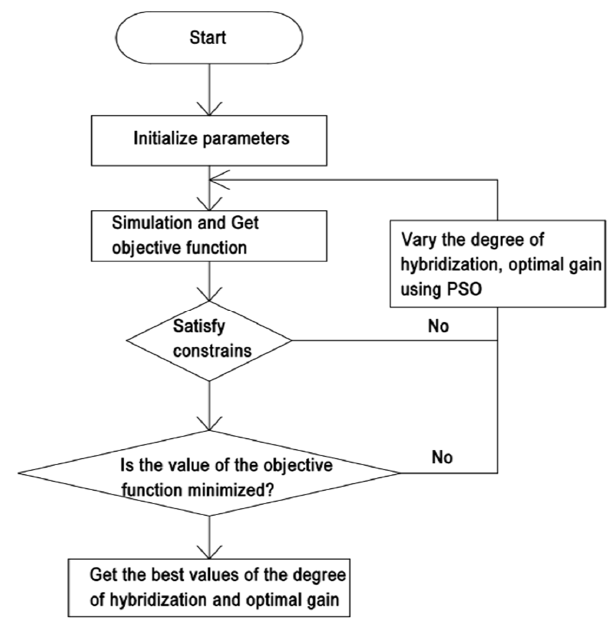
Figure 14. Flowchart of the implemented PSO.